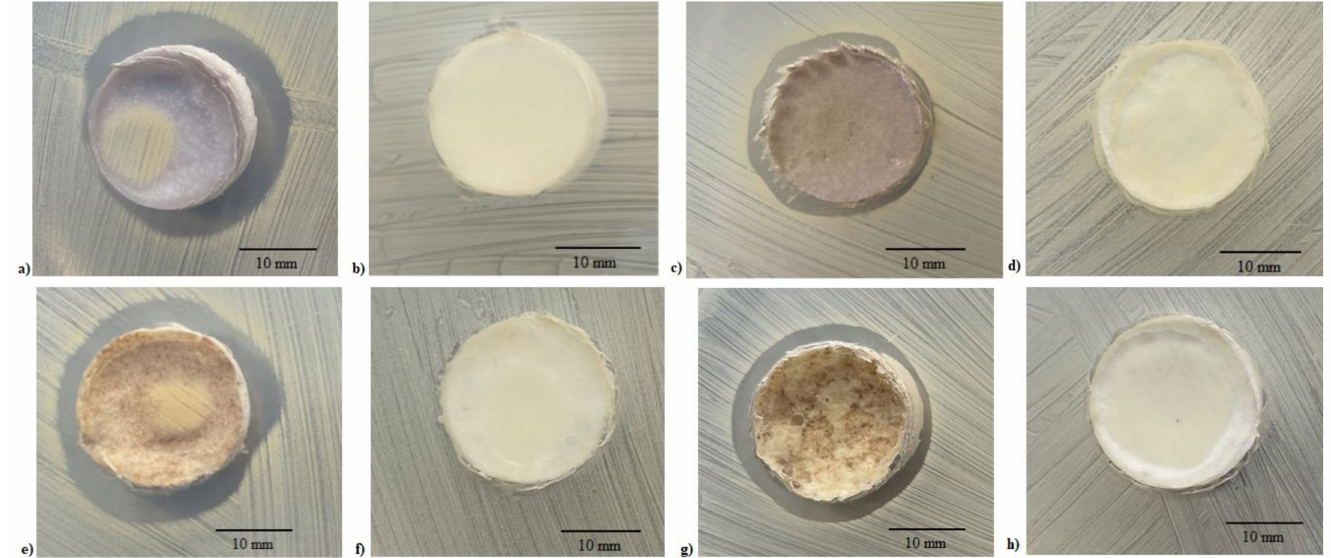
Figure 5. Representative images of the antibacterial tests on the PCL-based samples with NaCl [PCL + Ag, ( a ); PCL, ( b ); BCP/PCL + Ag, ( c ); BCP/PCL, ( d )] and NaNO 3 [PCL + Ag, ( e ); PCL, ( f ); BCP/PCL + Ag, ( g ); BCP/PCL, ( h )] performed by the inhibition